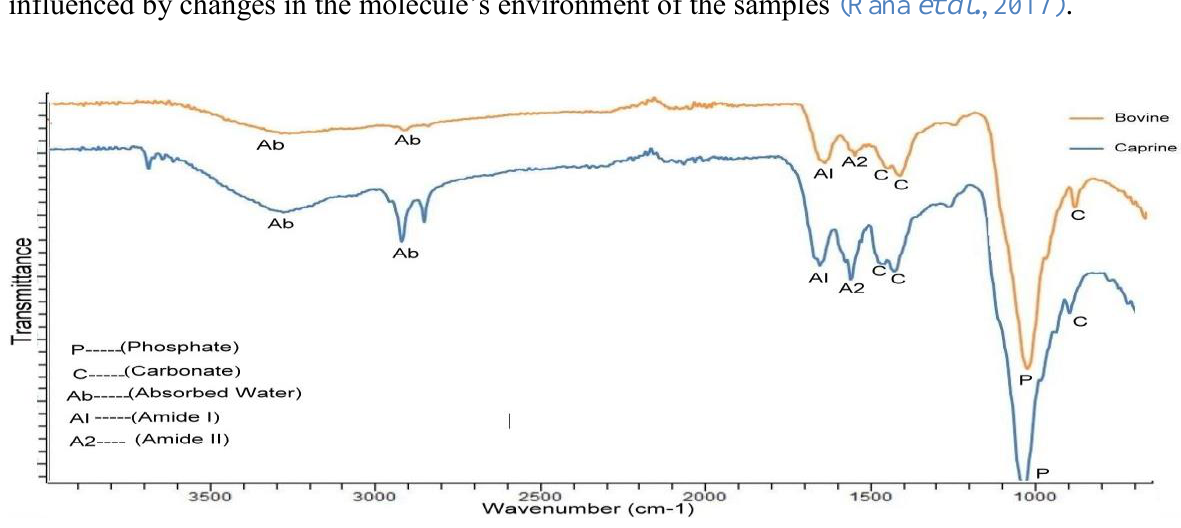
Fig. 4. FTIR spectrum of raw Bovine and Caprine